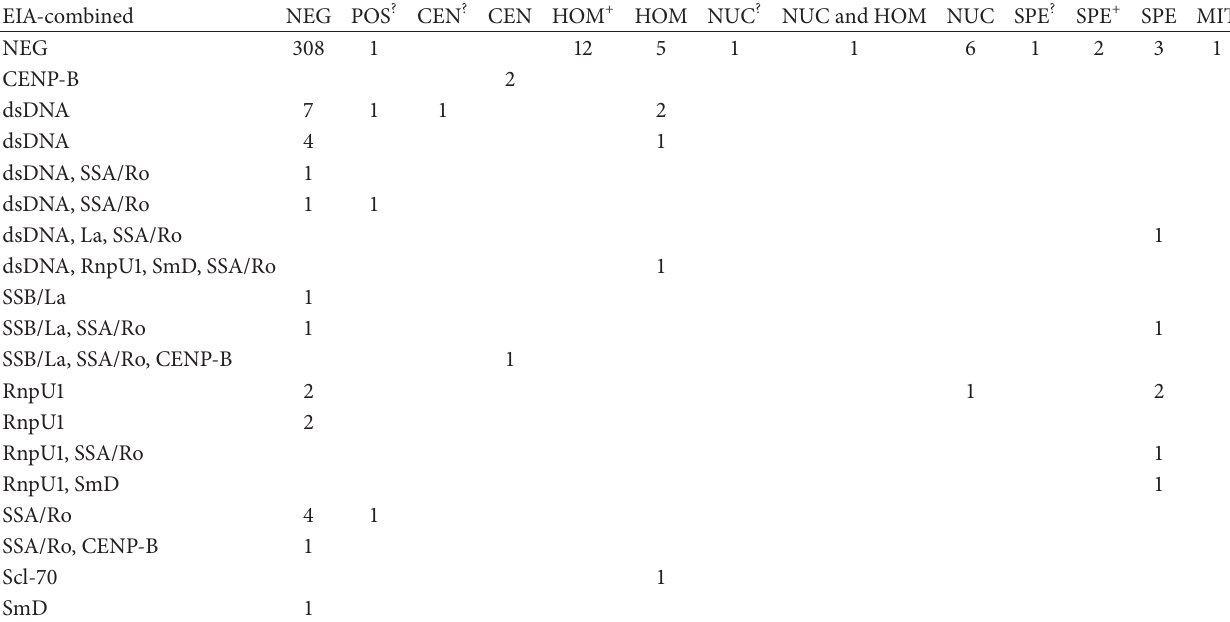
Table 3: Comparison of immunofluorescence patterns and titers between HEp-2000 immunofluorescence (Immuno Concept) and